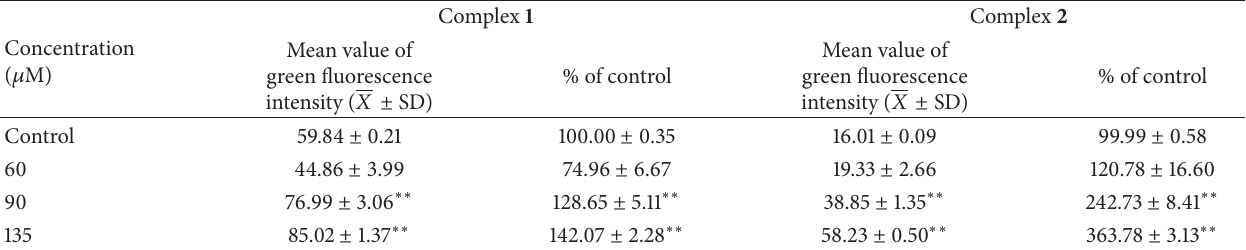
Table 4: Depolarization of mitochondrial membrane potential of the BEL-7402 cells treated with complexes 1 and 2 for 48h.